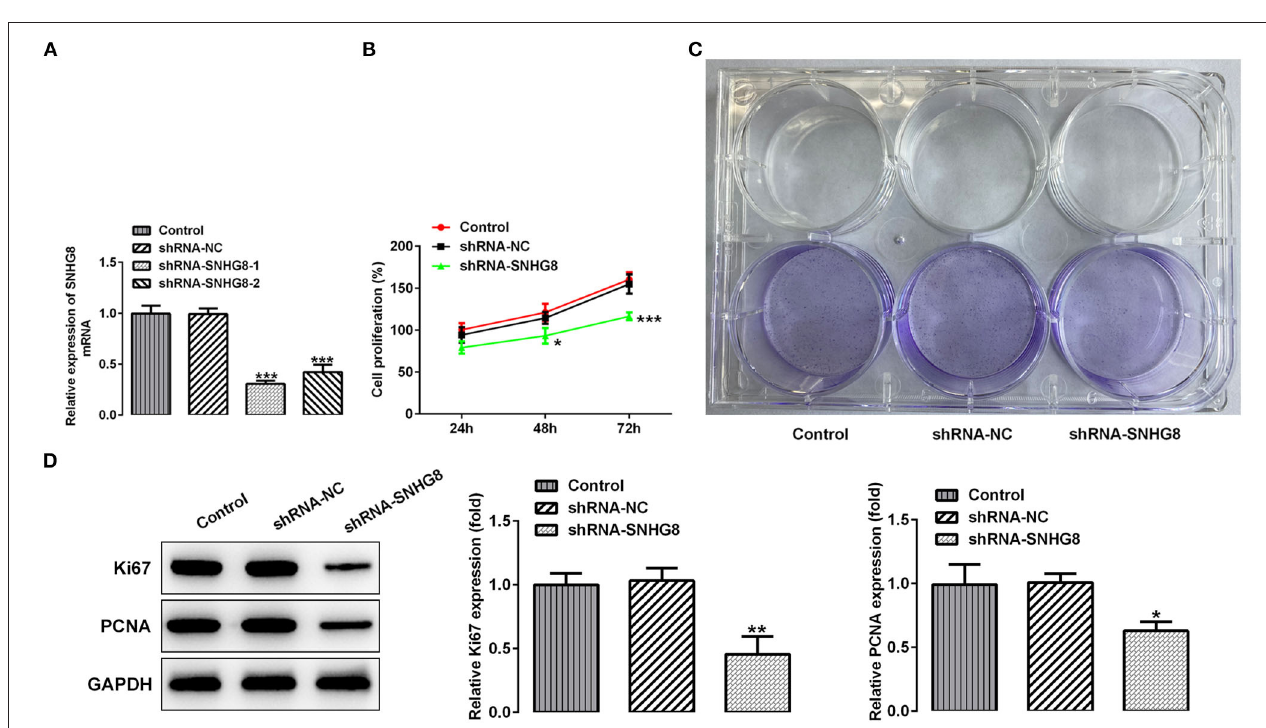
FIGURE 2 | The effect of SNHG8 silence on cell proliferation of DLBCL. (A) The mRNA expression of SNHG8 in U2932 cells transfected with the indicated vectors. (B) The cell proliferation rate of U2932 cells transfected with the indicated vectors was measured by the CCK-8 assay. (C) Representative colony formation analysis for U2932 cells in different groups. (D) The protein expression of Ki67 and proliferating cell nuclear antigen (PCNA) in U2932 cells were detected by Western blotting. * p < 0.05, ** p < 0.01, and *** p < 0.001 vs. short hairpin RNA of negative scrambled control (shRNA-NC).